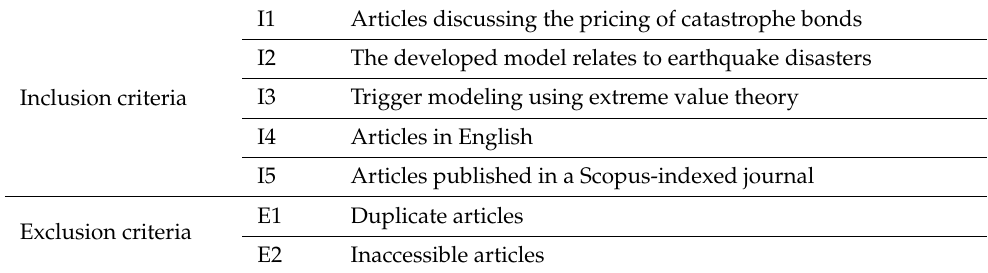
Table 3. The inclusion and exclusion